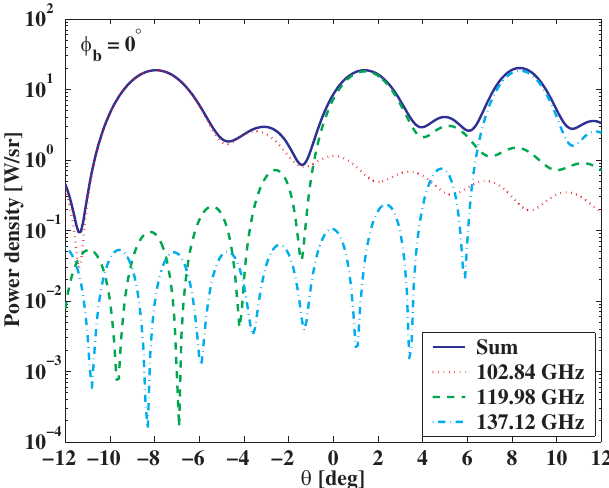
FIG. 4. (Color) First-order radiated power density calculated for (cid:2) 0 (cid:7) by the EFIE model and Eq. (3) (solid line). This (cid:6) b calculation was composed from the 6th (dotted line), 7th (dashed line), and 8th (dash-dotted line) harmonics of the accelerator